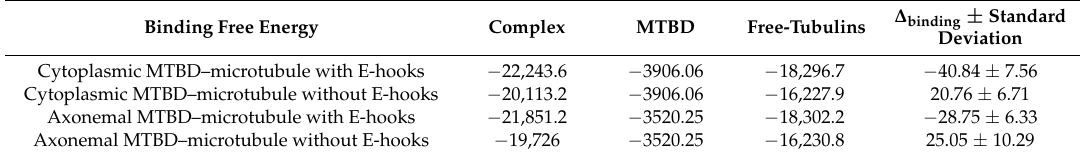
∆ binding ± Standard Deviation